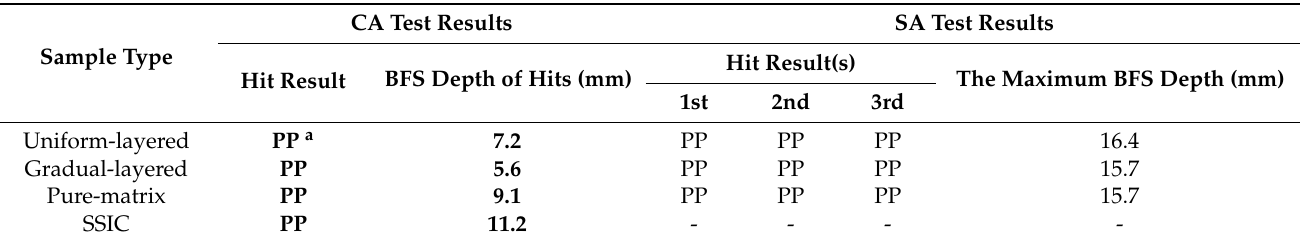
Table 3. Ballistic test results of the laminated SiC ceramics tested in conjunction with a flexible armor jacket (the CA test) and stand-alone (the SA test).